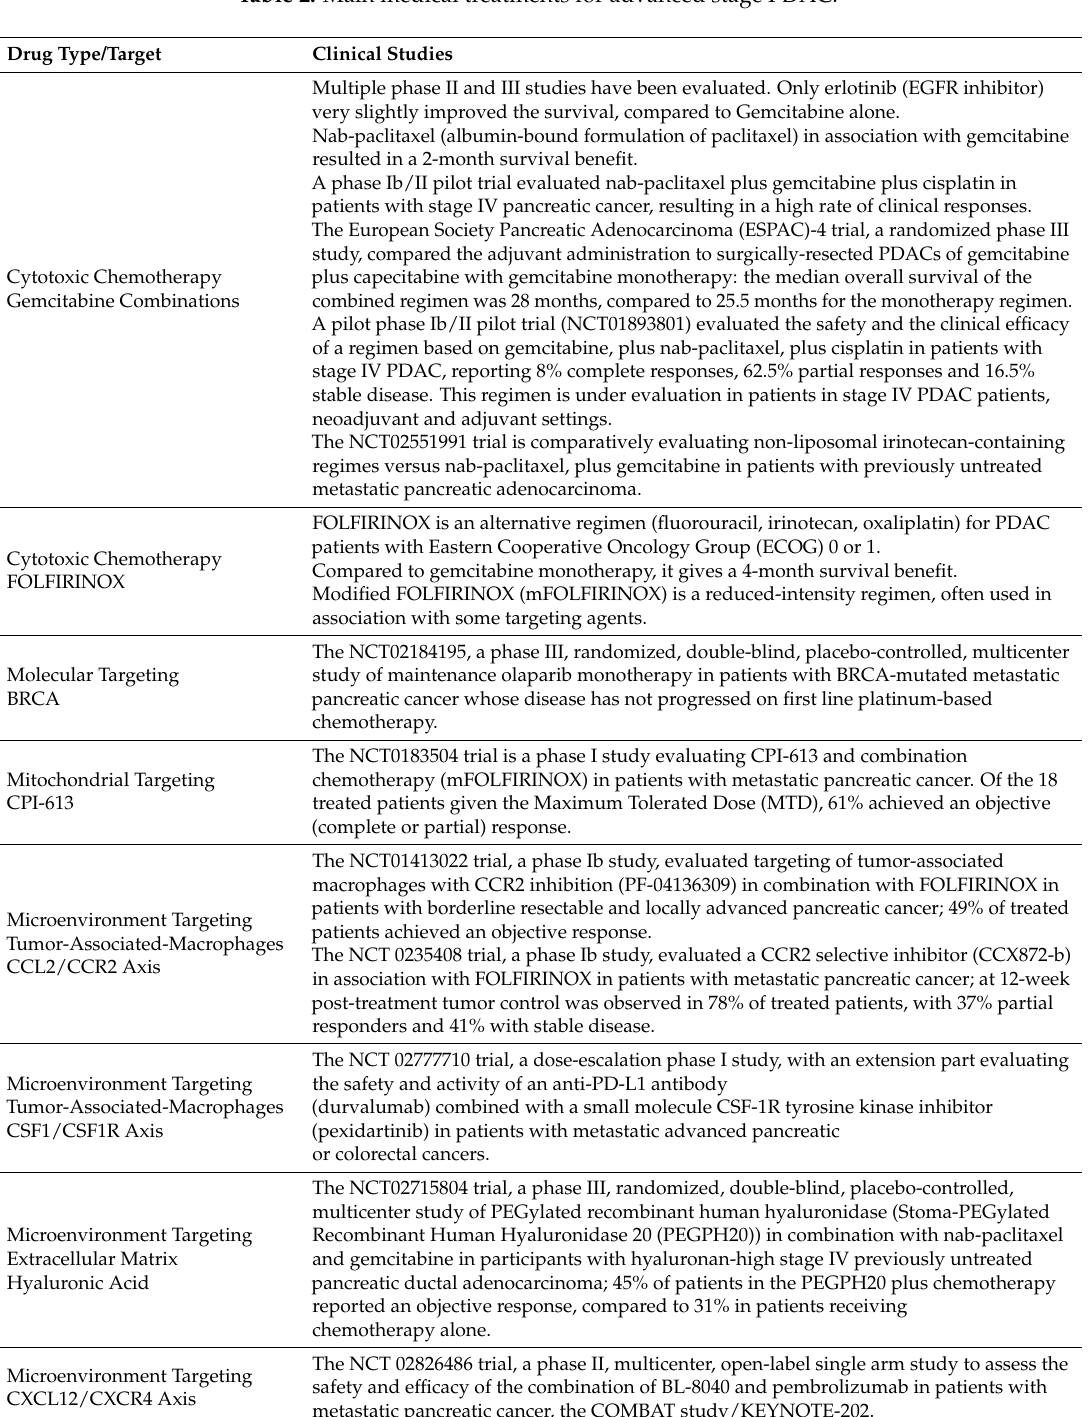
Table 2. Main medical treatments for advanced stage